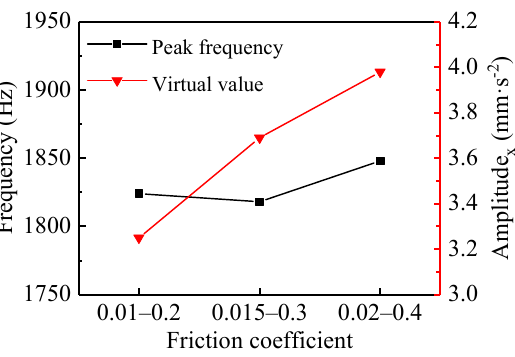
Figure 6. The peak frequency and root mean square (RMS) in the x-direction with di ff erent friction coe ffi